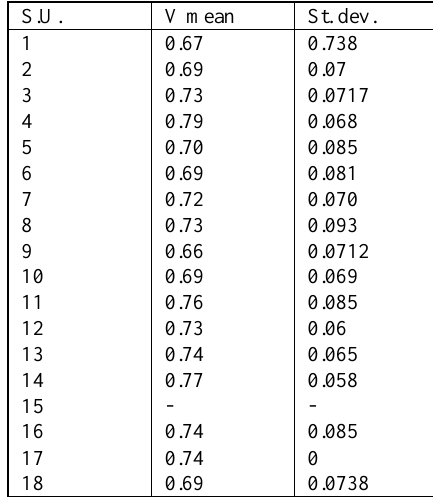
Table 1. V index for the different aggregates of Scarperia.